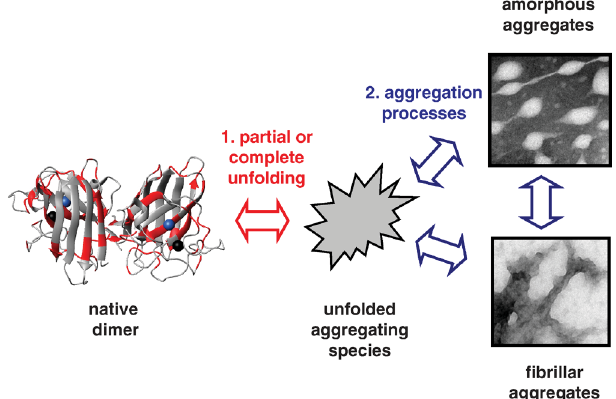
Figure 1. Misfolding and Aggregation of SOD1 Wang et al.’s correlation of mutant SOD1 properties with disease duration [6] implicates two steps in the formation of aggregates of SOD1 in ALS: (1) native homodimeric metalloprotein, shown in ribbon representation (left) partially or completely unfolds to form a range of possible dimeric or monomeric aggregation-prone species, shown as a general grey irregular shape (middle), followed by (2) progressive assembly of the aggregation-prone species to form initially small soluble and later fibrillar aggregates (right panels). The structure of native SOD1 was generated using MolMol [29] and Protein Data Bank accession code 1n18. Sites of ALS-associated mutations studied by Wang et al. are shown in red; bound copper and zinc ions are shown as blue and black spheres, respectively. The right panels are transmission electron microscopy images of apo SOD1 aggregates formed in vitro that strongly resemble granular and granule-coated fibrillar SOD1 aggregates observed in ALS